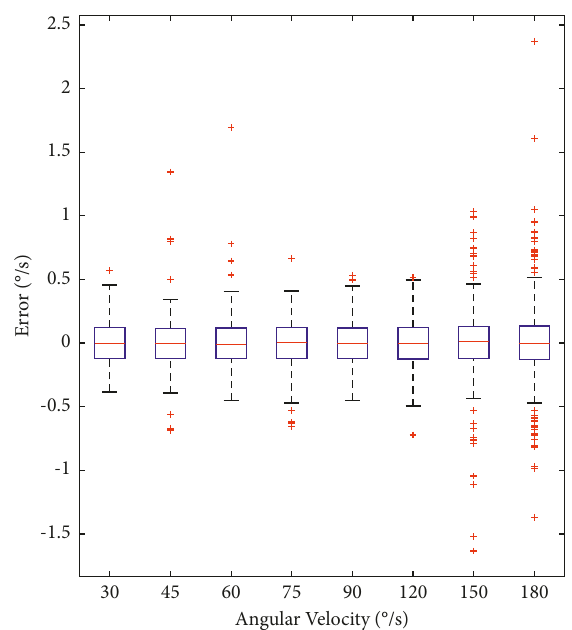
Figure 8: The statistics and distribution of errors between reference speed and FOFPID controller speed response under various joint angular velocities.